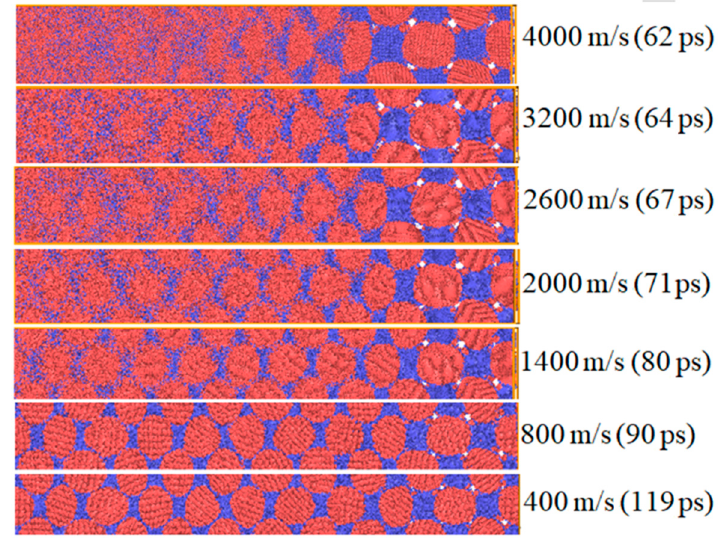
Figure 9. Particle morphology under different impact strength.